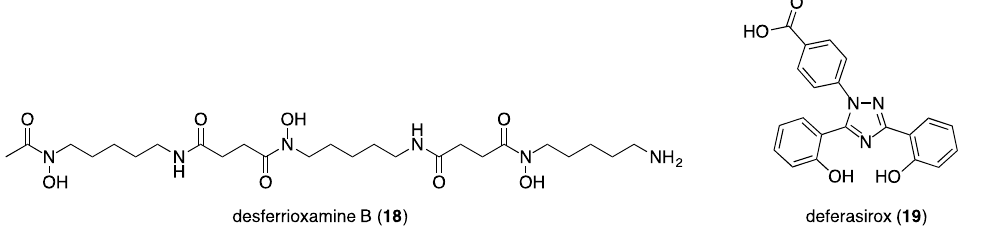
Figure 6. Structure of desferrioxamine B (DFO) and deferasirox.